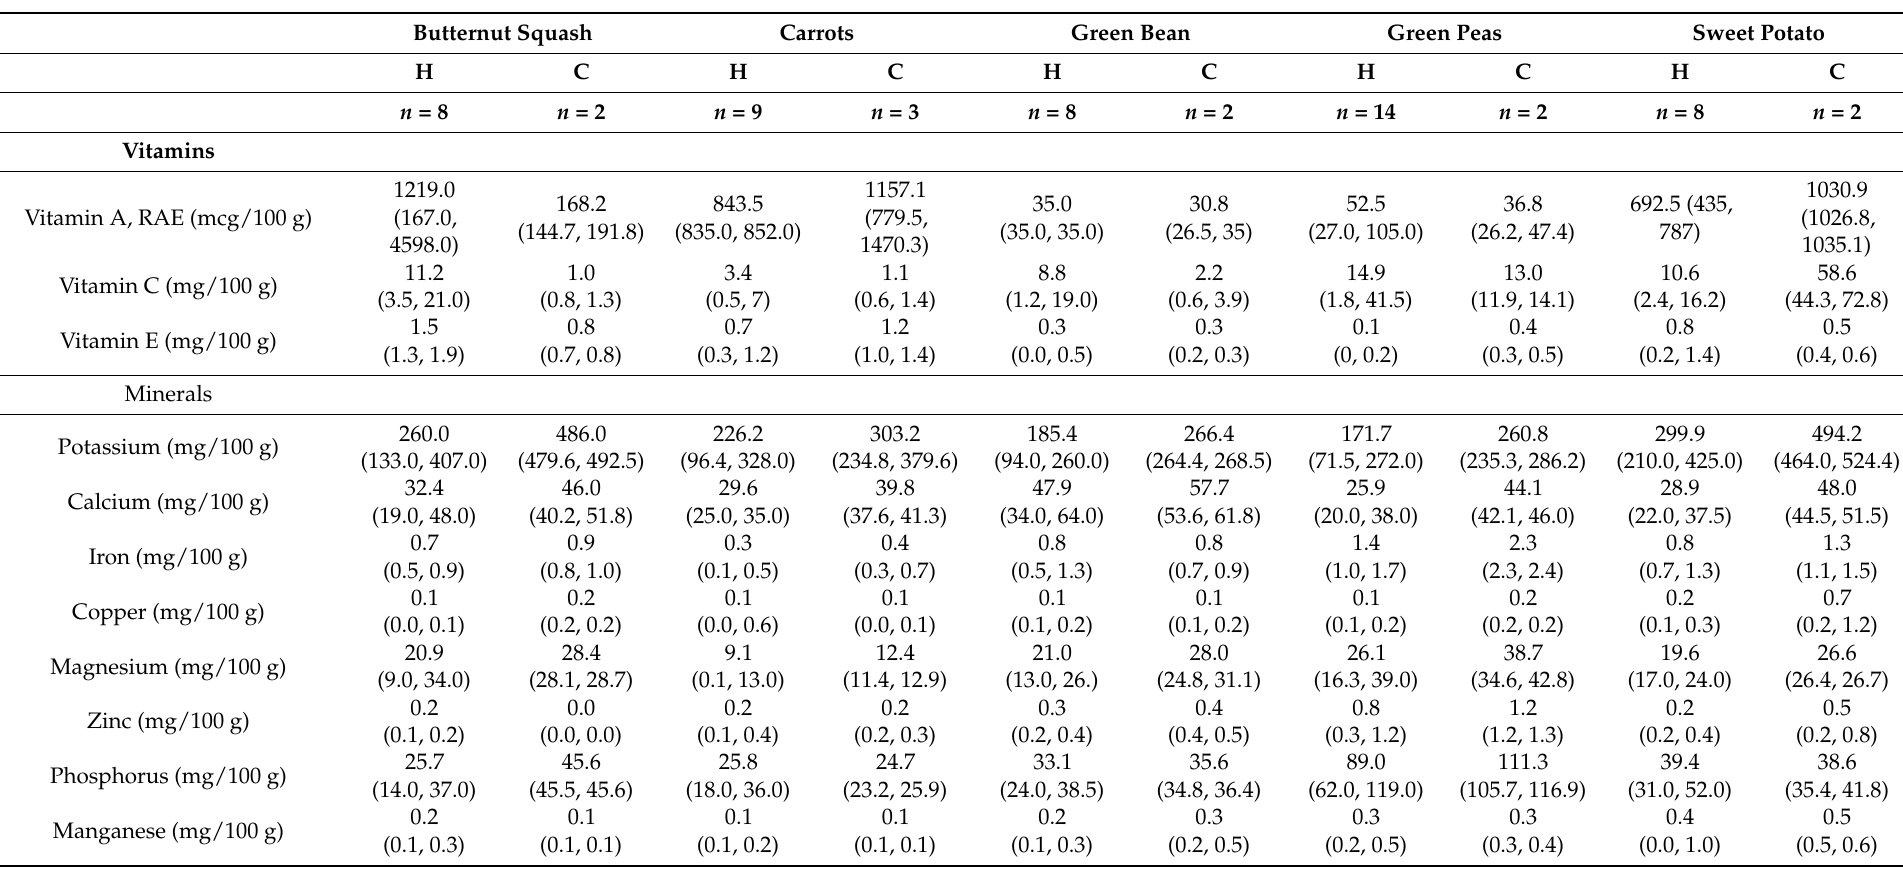
Table 4. Comparison of the food profiles (per 100 g) of external food composition databases and the nutritional profiles of chemically analyzed